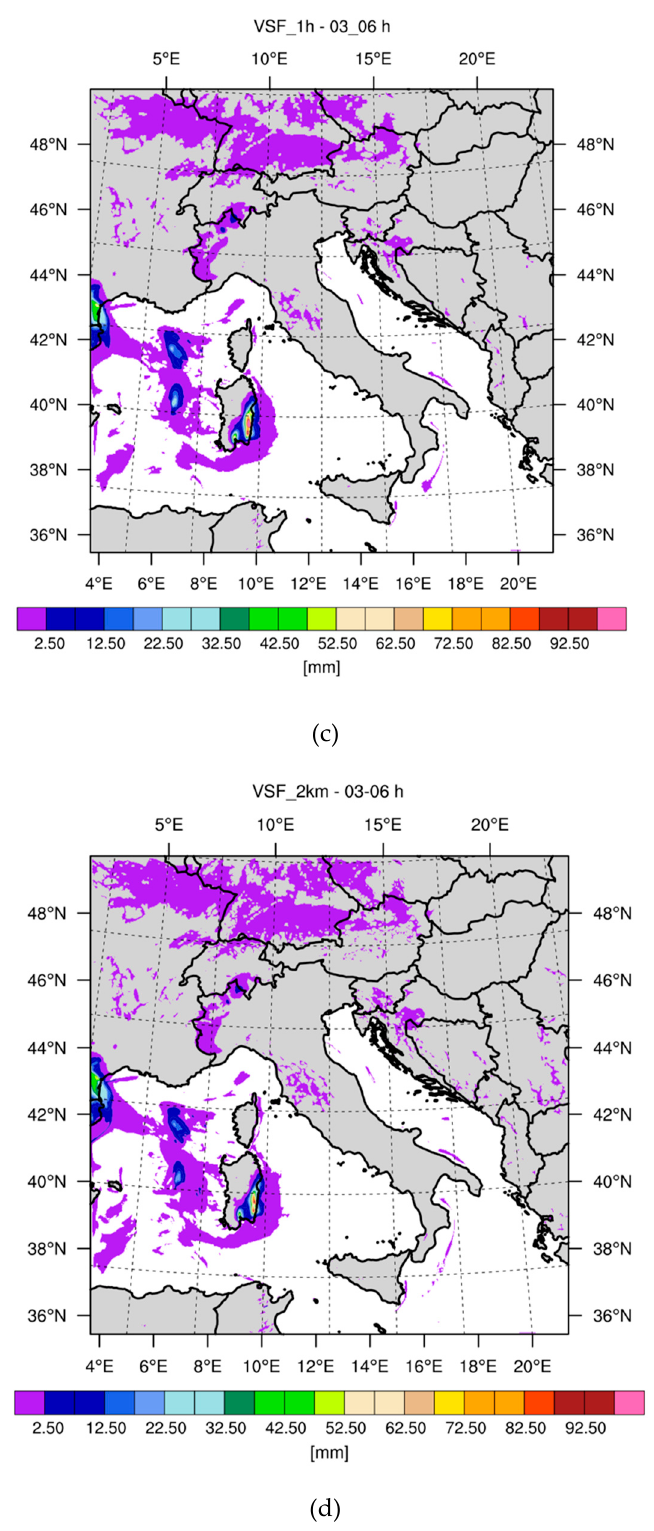
Figure 7. Accumulated precipitation between 03 UTC and 06 UTC on 10 October 2018 for ( a ) CTRL; ( b ) VSF_3h; ( c ) VSF_1h; ( d ) VSF_2km. For VSF_1h and VSF_2km the precipitation is given by the sum of the three very short term forecast of 1 h between 03 and 06 UTC.